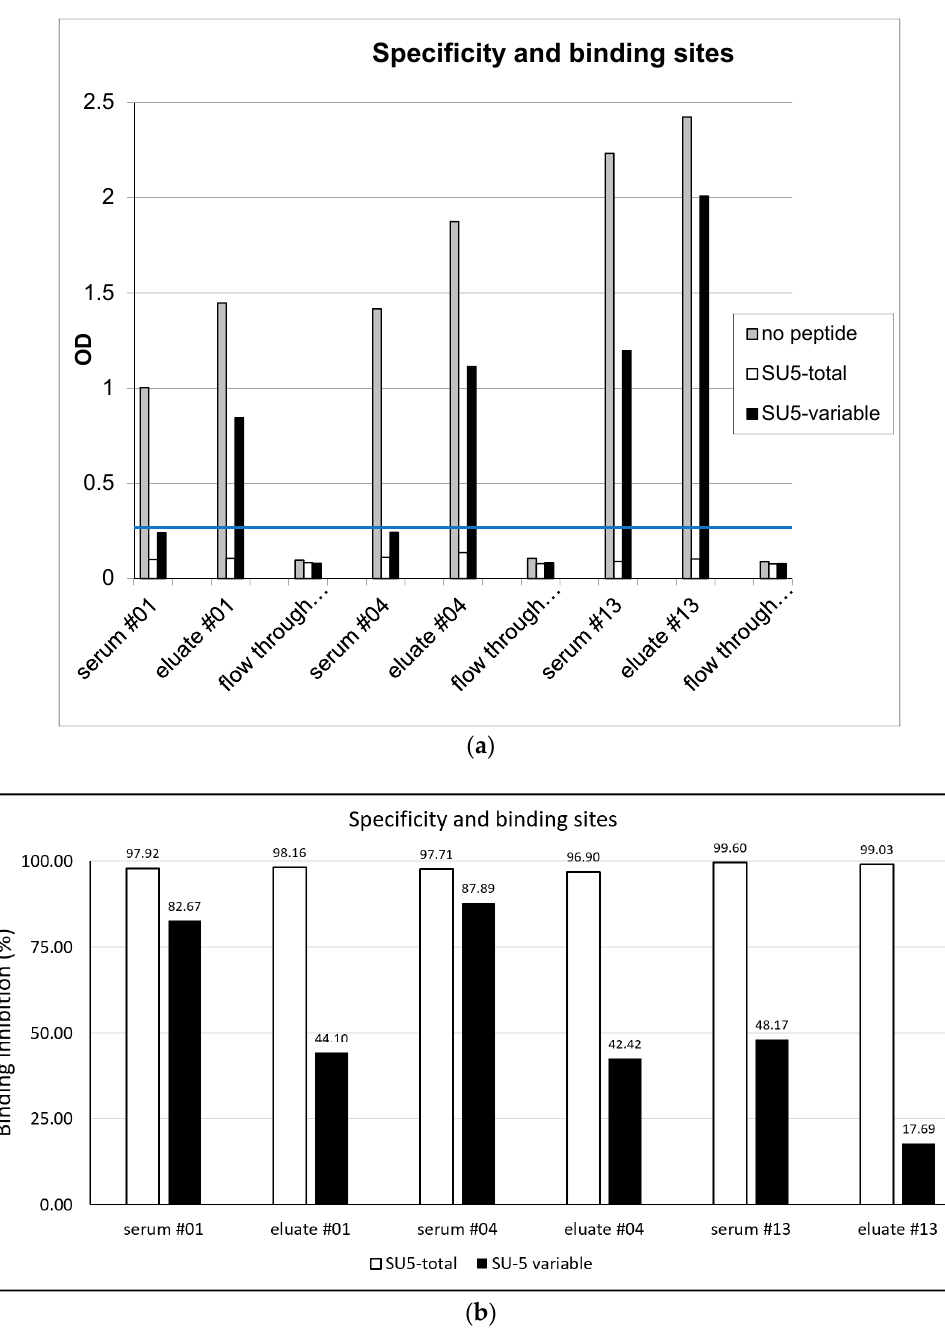
Figure 1. ( a ) Specificity and binding sites: Unfractionated sera, affinity purified anti-SU5 antibody present in the column eluate and antibody in the flow through were tested in a SU5-total peptide ELISA. The addition of SU5-total peptide completely suppressed binding, confirming the specificity of the reaction. A fraction of the antibodies present in the eluate bound to the variable part of SU5 and their binding was blocked by the addition of the SU5-variable peptide (confirmed in a SU5-variable ELISA). The remaining antibody in the eluate bound to a region overlapping the variable and constant regions. Anti-SU5 antibody is efficiently depleted from the column flow through. The blue line at OD 0.3 represent an arbitrary cutoff. ( b ) Specificity and binding sites: Pre-incubation of the antibody preparations with SU5-total peptide (open bars), or SU5-variable peptide (filled bars) inhibited antibody binding to SU5-total peptides coated on an ELISA plate (expressed as % binding inhibition, see ( a